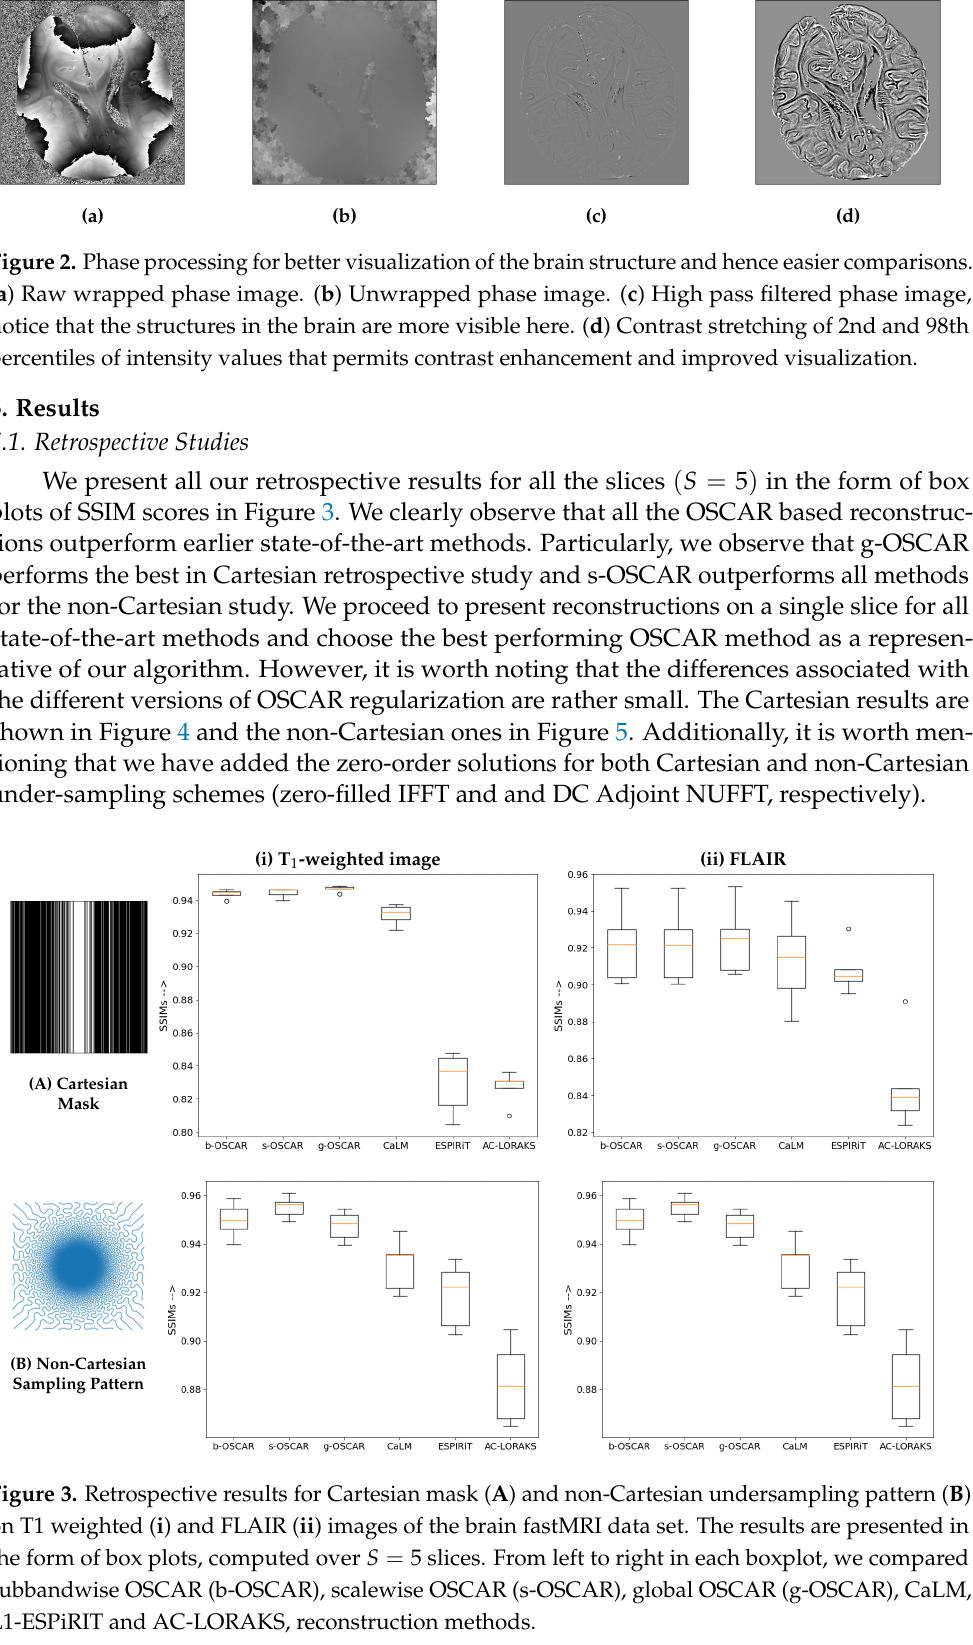
Figure 3. Retrospective results for Cartesian mask (A) and non-Cartesian undersampling pattern (B) on T1 weighted (i) and FLAIR (ii) images of the brain fastMRI data set. The results are presented in the form of box plots, computed over S = 5 slices. From left to right in each boxplot, we compared subbandwise OSCAR (b-OSCAR), scalewise OSCAR (s-OSCAR), global OSCAR (g-OSCAR), CaLM, L1-ESPiRIT and AC-LORAKS, reconstruction methods.